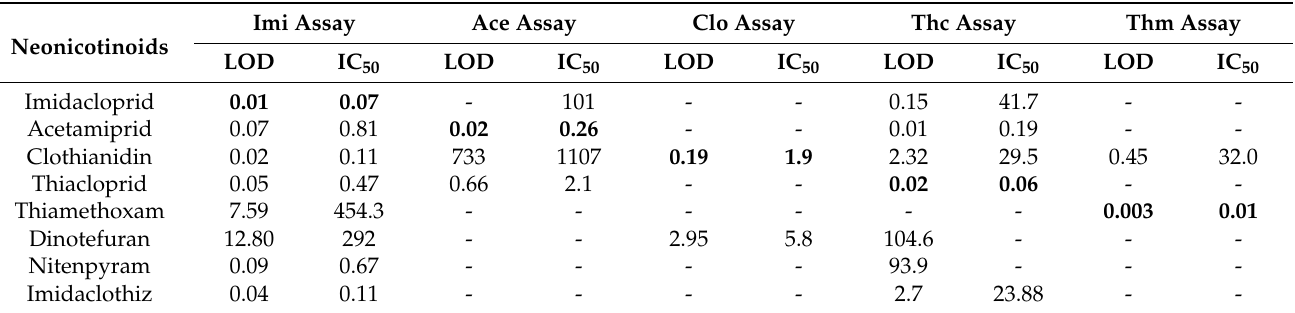
Table 3. Single nMIAs and their cross-reactive sensitivities (ng/mL) for all eight of the target neonicotinoids that are expressed in the limits of detection and IC 50